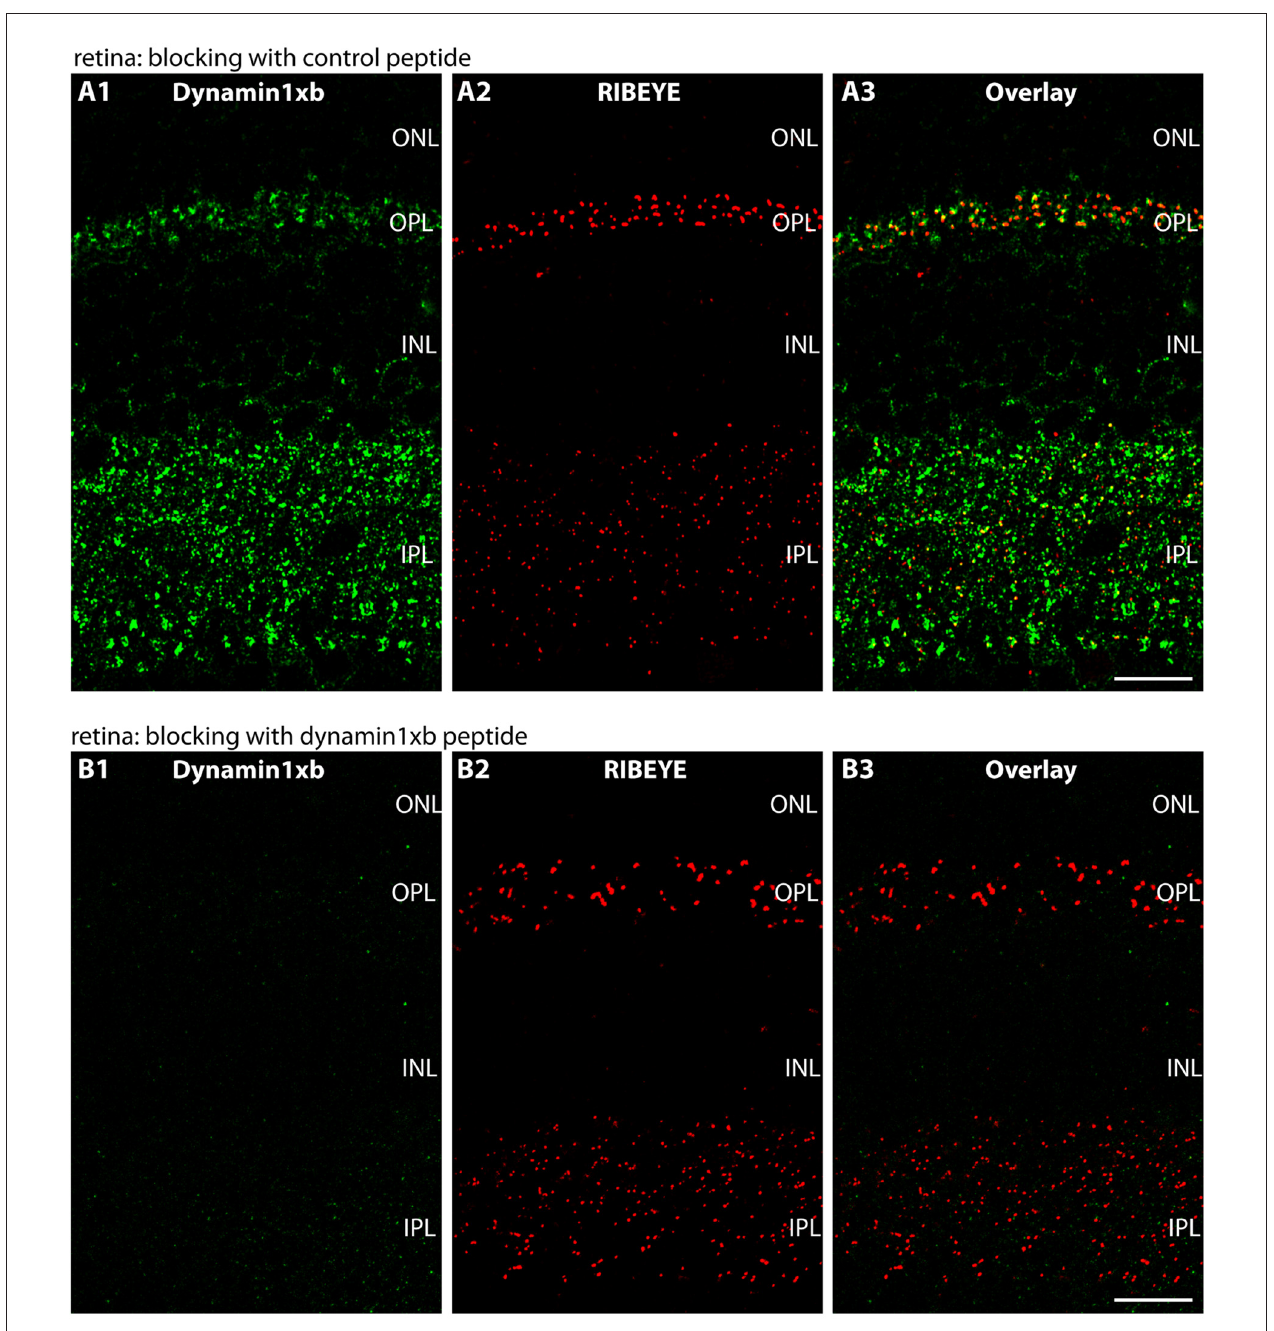
FIGURE 4 | Semi-thin (0.5 µ m-thin) sections of the mouse retina immunolabeled with the monoclonal dynamin1xb antibody that was pre-absorbed either with a control peptide (A) or with the dynamin1xb peptide “PP12” against which the monoclonal antibody was raised (B) . The strong dynamin1xb immunosignal is completely absent if the antibody against dynamin1xb is pre-absorbed with “PP12” whereas the synaptic immunolabel is completely unaffected if a control peptide was used. The RIBEYE immunolabeling was unaffected by both of these treatments. Figure 4 was obtained by confocal microscopy. Abbreviations: ONL, outer nuclear layer; OPL, outer plexiform layer; INL, inner nuclear layer; IPL, inner plexiform layer. Scale bars: 20 µ m.